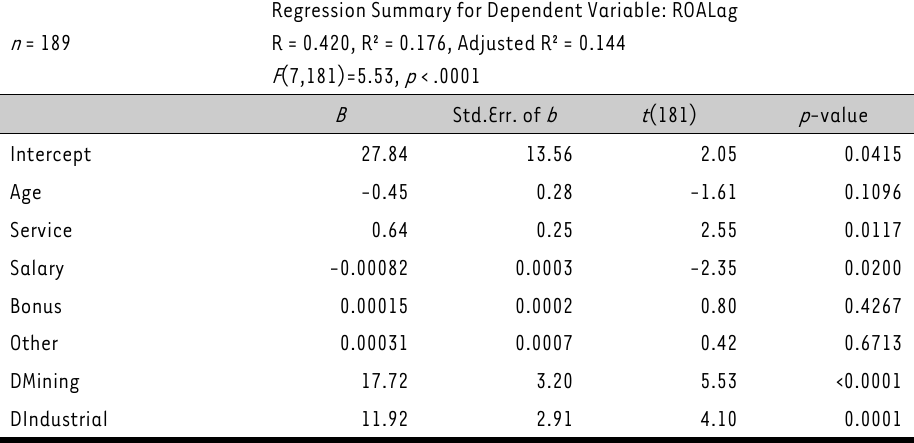
TABLE 10: Econometric Model 5 showing ROA lagged as the dependent variable Regression Summary for Dependent Variable: n = 189